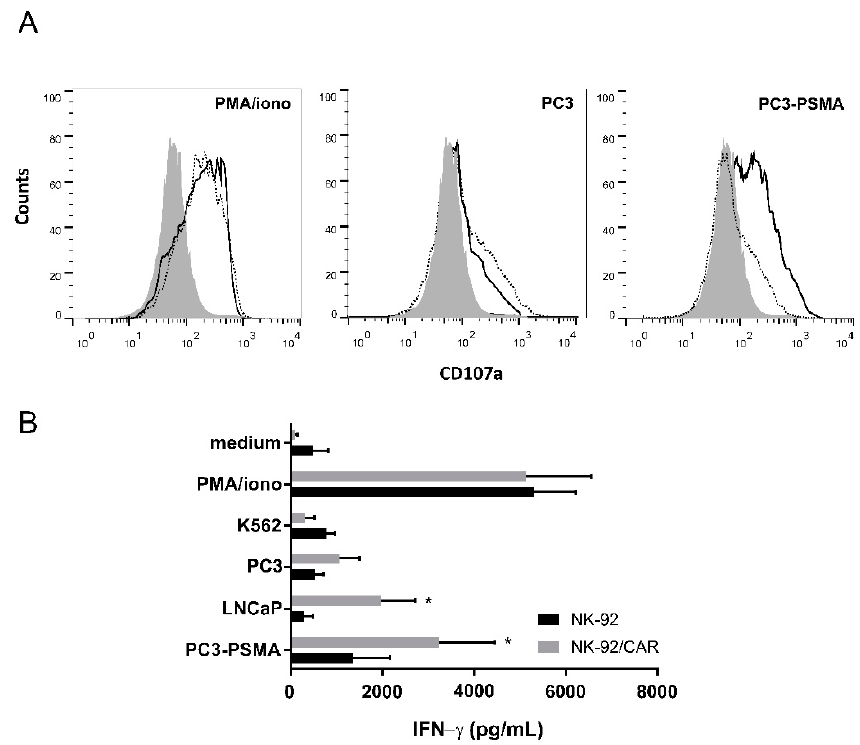
Figure 3. Degranulation and IFN- γ secretion by irradiated NK-92/CAR cells upon engagement with PSMA-expressing prostate cancer cells. ( A ) Degranulation of NK-92/CAR cells (solid lines) was analyzed by flow cytometry assessment of CD107a surface expression after 5h of co-culture with PC3 or PC3-PSMA cells. Parental NK-92 cells (dotted lines) were included for comparison. Effector cells kept alone (shaded areas) or stimulated with PMA/ionomycin served as basal and positive controls, respectively. ( B ) IFN- γ release was analyzed in supernatants of NK-92/CAR cells stimulated with PSMA-negative or -positive cancer cell lines. NK-92/CAR cells treated with PMA/ionomycin served as positive controls. Parental NK-92 cells were included for comparison. Results are reported as mean values ± SD of 3 independent experiments. * p < 0.05.